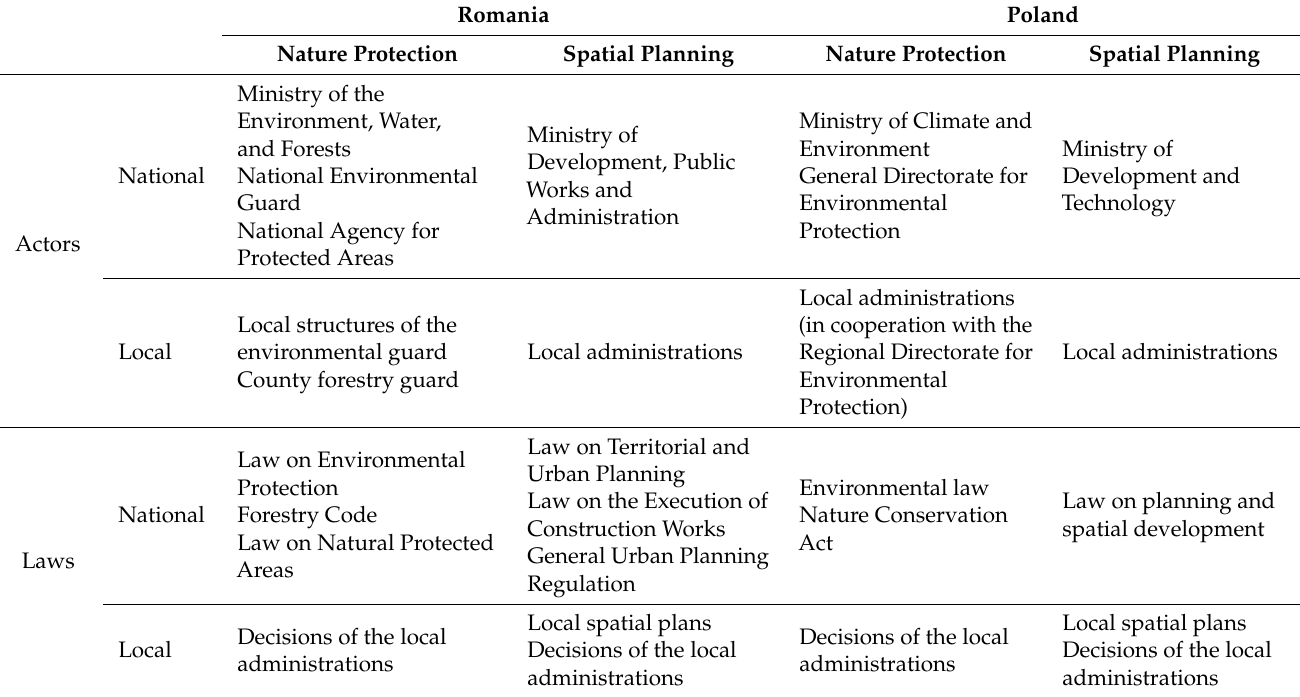
Table 4. Overview of the main actors and laws governing protection of natural assets and spatial planning in Romanian and